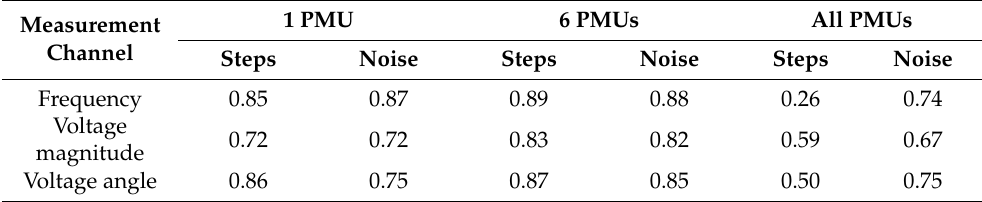
Table 5. Total F1-scores of the GRU-AC model for different PMU step and noise manipulations. Measurement